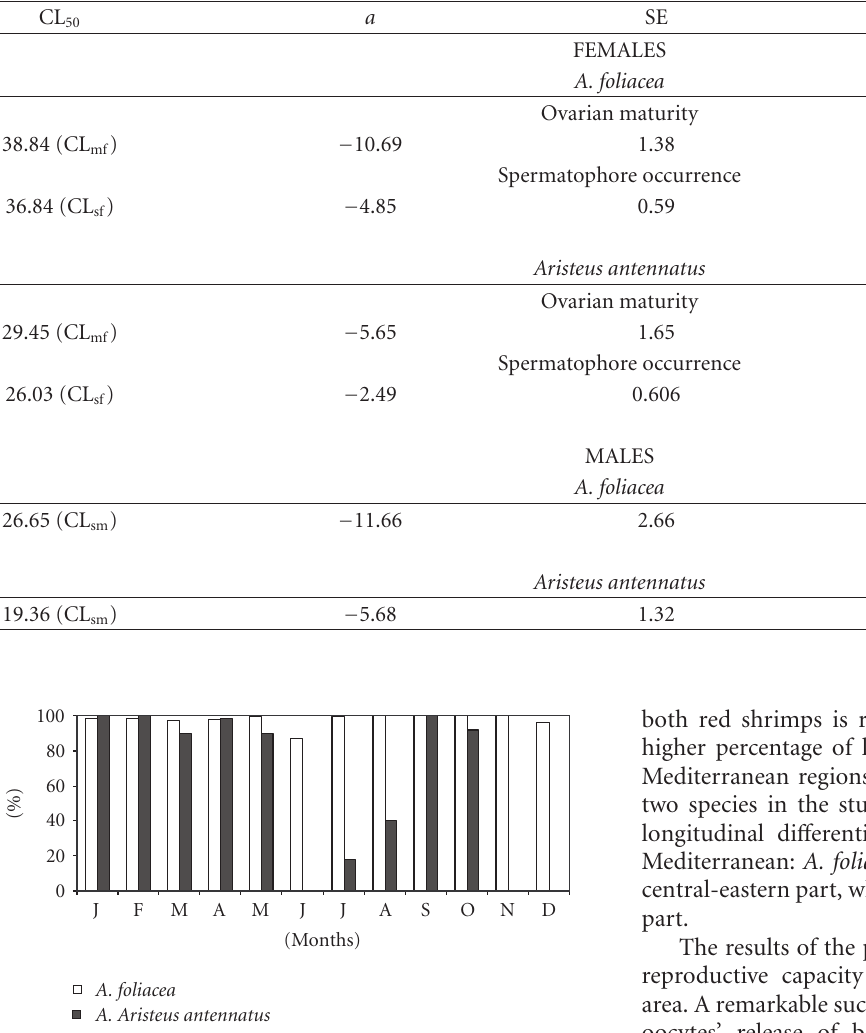
Table 4: Elements of the logistic model ( P = 1/[1+ e ( ax + b CL) ]) for the mature (CL mf ), mated (CL sf ) females and mature males (CL sm ) of A. foliacea and Aristeus antennatus .